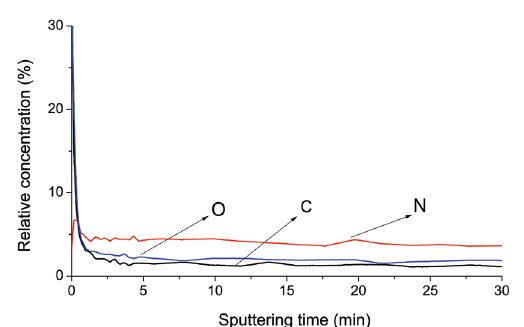
Figure 7. Elemental depth profile for a Nb sample submitted to pulses of 5kV/20 μ s/300Hz, heated at 900 °C, for 15